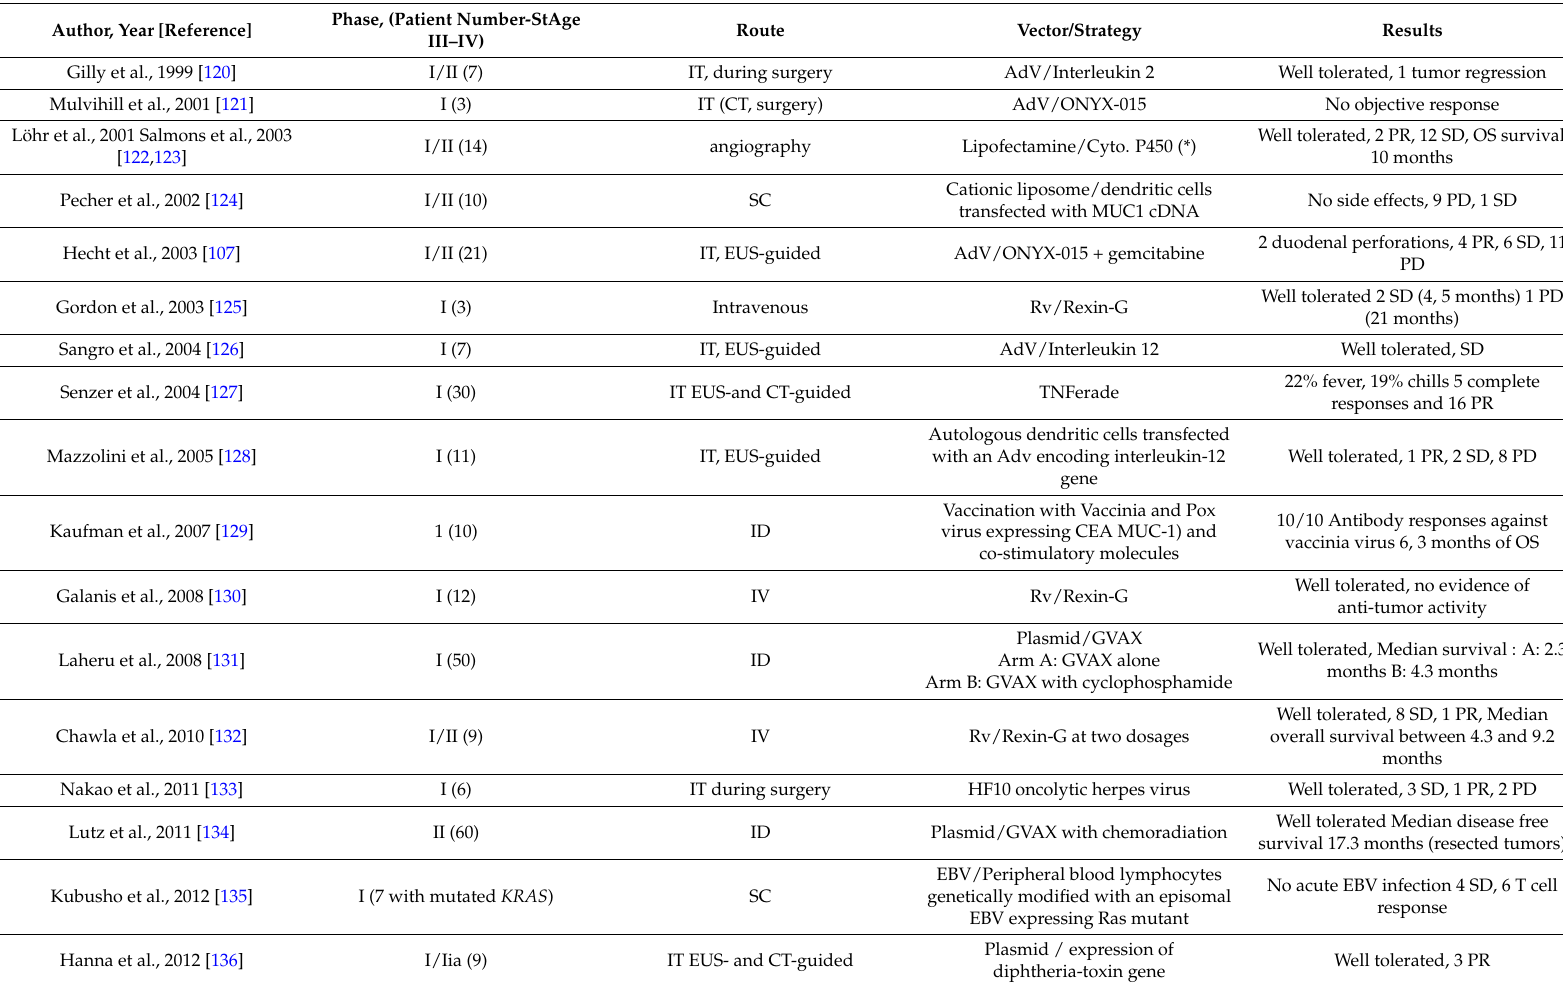
Table 3. Main published clinical trials of gene therapy for pancreatic